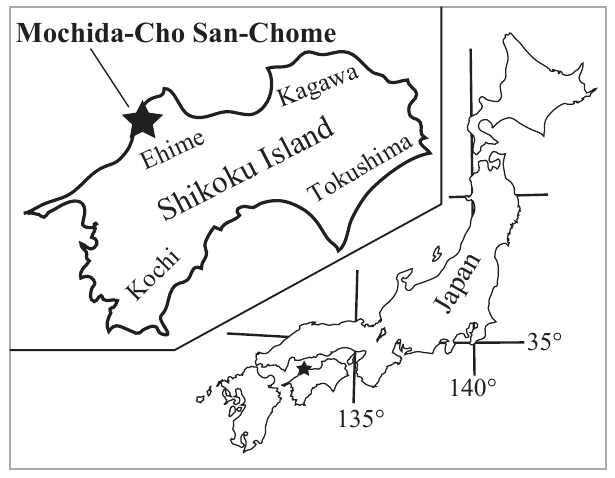
Figure 1. Map showing the location of the Mochida-Cho San-Chome site. This Early Yayoi cemetery is located on the Matsu- yama plain in the north-western part of Shikoku Island in the Japanese